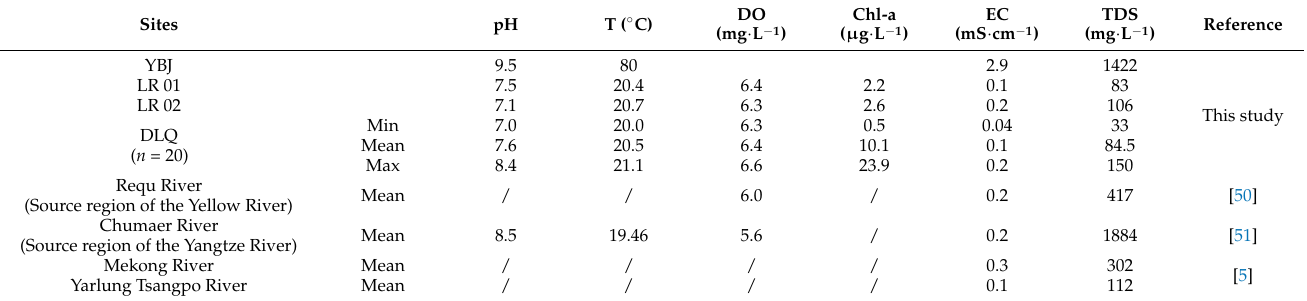
Table 1. Physical-chemical parameters of surface water in the DLQ, LR, and YBJ geothermal water.